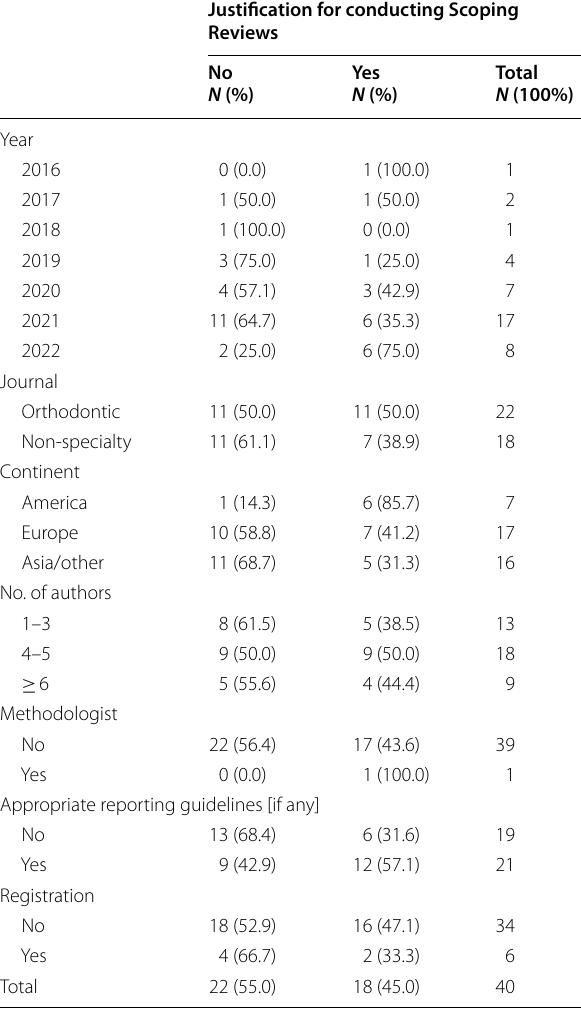
Table 1 Characteristics of Scoping Reviews (ScRs), by